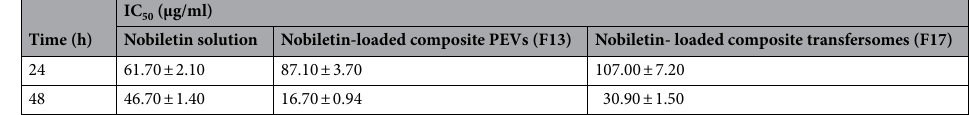
Table 3. IC 50 values of nobiletin solution, composite PEVs (F13) and composite transfersomes (F17) on A431 cell line after 24 and 48 h (n = 3).